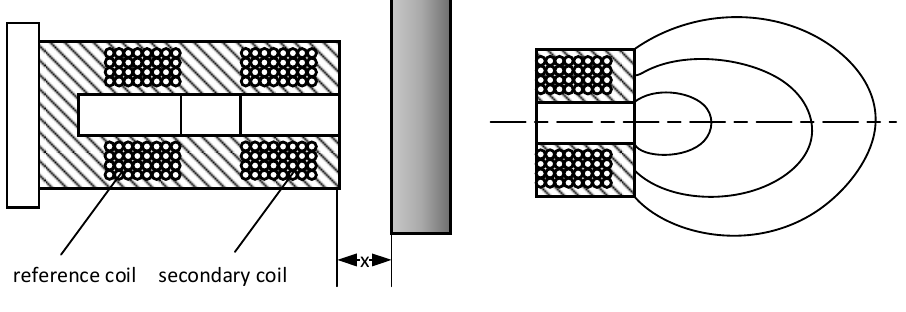
Figure 4. Eddy ‐ current converter. Figure 4. Eddy-current